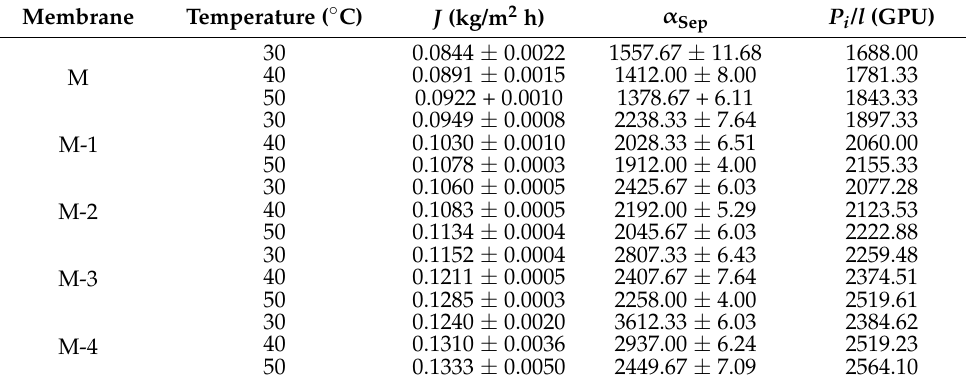
Table 1. Permeation flux, separation selectivity and permeance data of the developed membranes at various